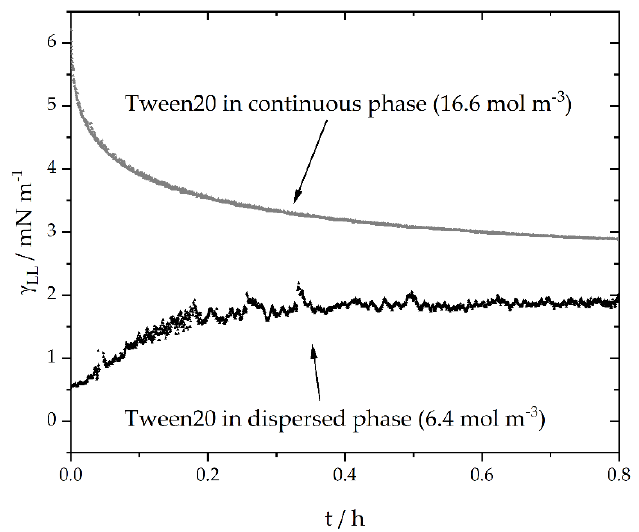
Figure 5. Two exemplary time-resolved specific interfacial energy ( 𝛾 (cid:3013)(cid:3013) ) measurements with surfac- tant supported in either the aqueous, continuous ( 𝑐̃ (cid:3021)(cid:3024)(cid:2870)(cid:2868)(cid:3009)(cid:2870)(cid:3016) (𝑡 = 0) = 16.6 mol·m − 3 ) or dispersed oil ( t = 0 ) = 16.6 mol · m − 3 ) or dispersed oil tant supported in either the aqueous, continuous ( (cid:101) c H 2 O TW 20 phase ( 𝑐̃ (cid:3021)(cid:3024)(cid:2870)(cid:2868)(cid:3035)(cid:3032)(cid:3051) (𝑡 = 0) = 6.4 mol·m − 3 ). ( t = 0 ) = 6.4 mol · m − 3 ). phase ( (cid:101) c hex TW 20